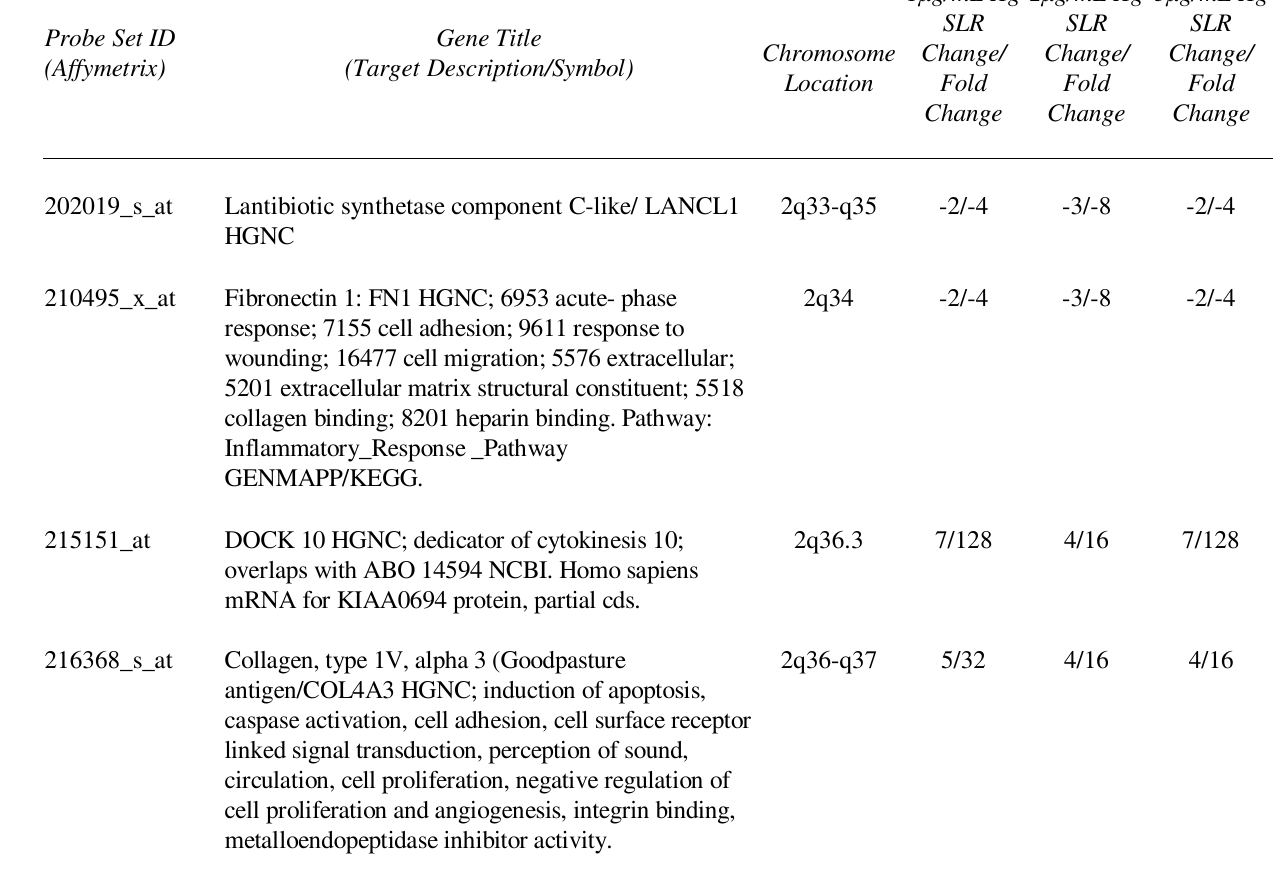
Table 1 contd.: Sample genes affected by mercury. Probe Set